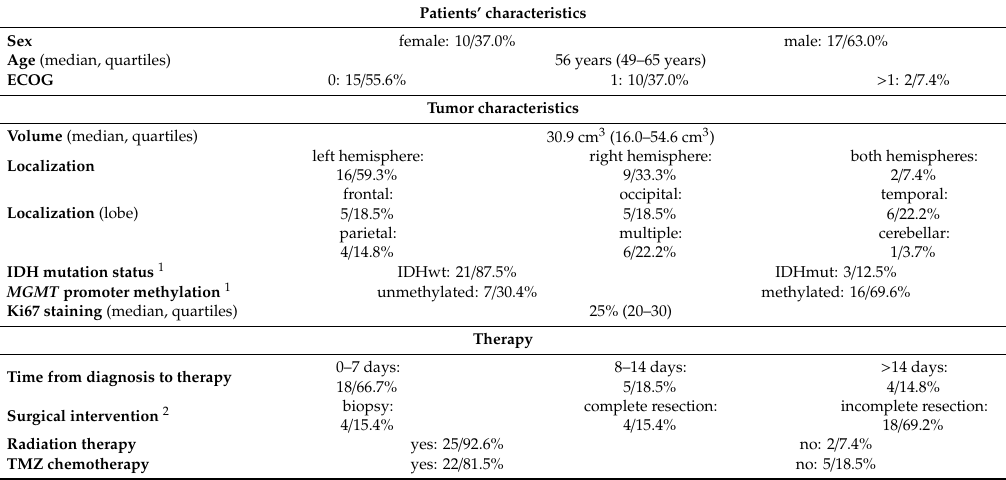
Table 1. Clinical parameters of glioblastoma multiforme (GBM) patients ( n = 27). Patients’